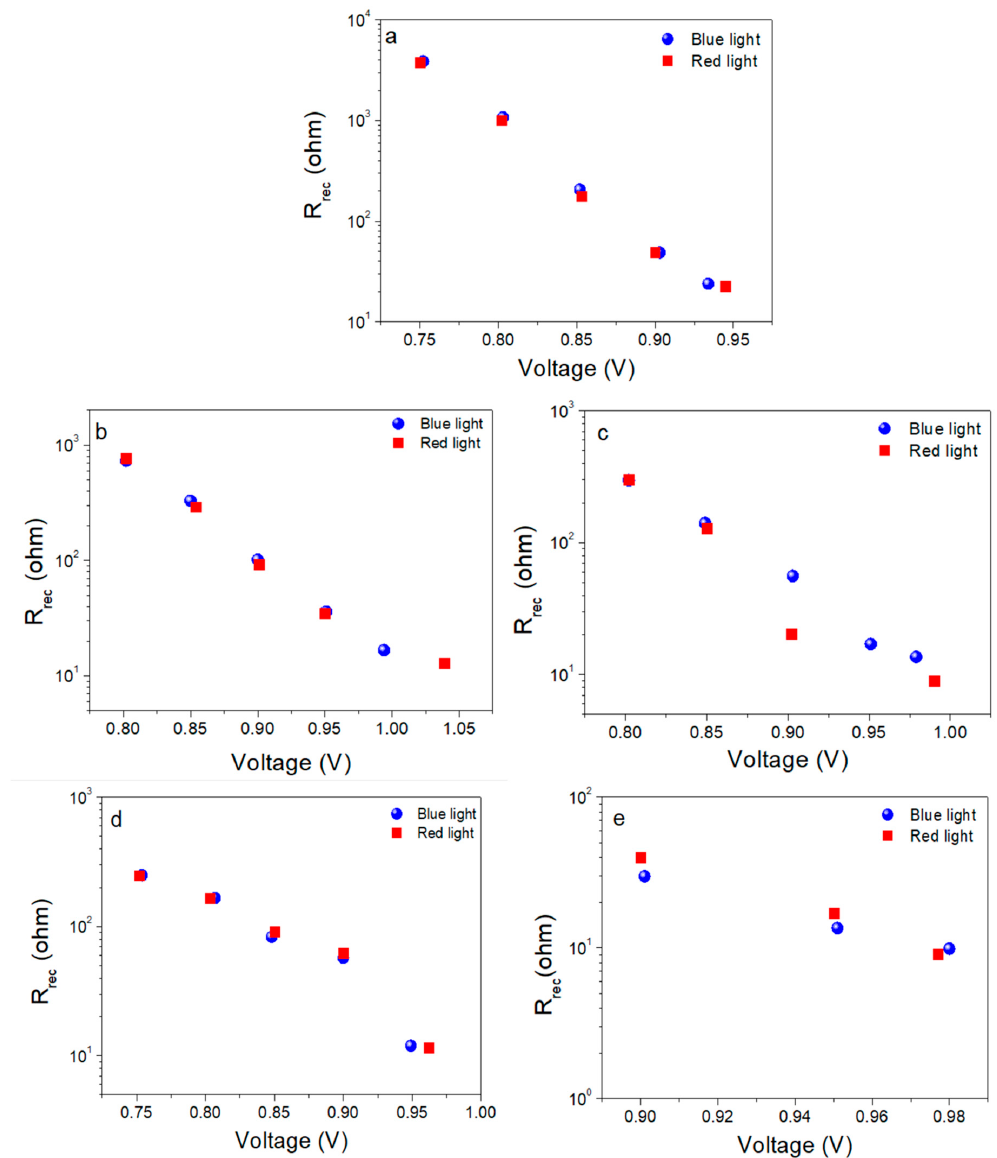
Figure 4. Nyquist ( a – e ) and Bode plots ( a` – e` ) at different applied voltages for CH 3 NH 3 PbI 3 perovskite solar cells using two excitation wavelengths, λ blue = 465 nm and λ red = 635 nm. Different configurations are labeled as follows: ( a , a` ) planar, ( b , b` ) mesoporous 1:7, ( c , c` ) mesoporous 1:3.5, ( d , d` ) nanocolumns 100 nm and ( e , e` ) nanocolumns 200 nm. Arrows indicate the evolution of the measurements when we measured from V OC to lower values.